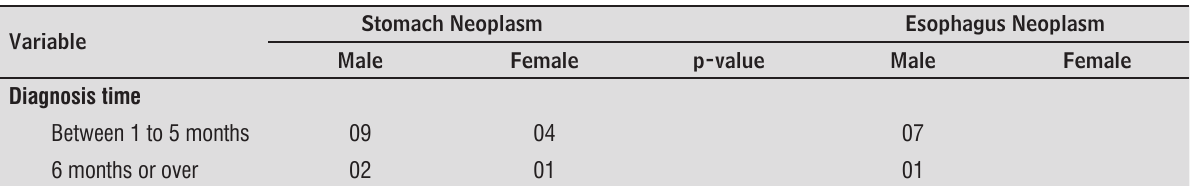
Table 1 - Patients anthropometric and clinical characteristics Variable